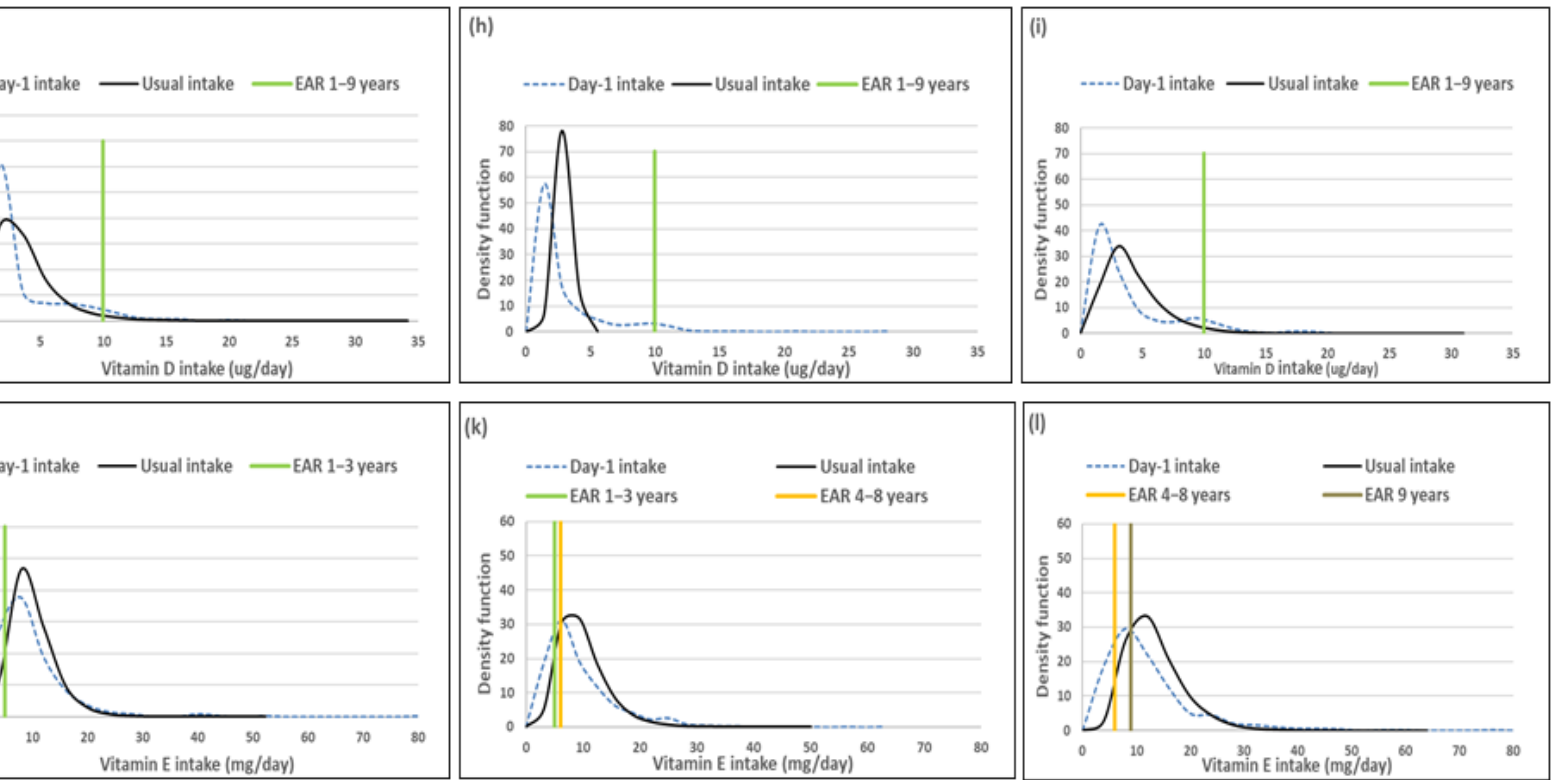
Figure 2. Distributions of the simulated, back-transformed values (usual intake) and the distribution of Day-1 intakes within the context of DRI-values of vitamins A, C, D and E, by age group. ( a ): Age 1–<3 years: Vitamin A intake; ( b ): Age 3–<6 years: Vitamin A intake; ( c ): Age 6–<10 years: Vitamin A intake; ( d ): Age 1–<3 years: Vitamin C intake; ( e ): Age 3–<6 years: Vitamin C intake; ( f ): Age 6–<10 years: Vitamin C intake; ( g ): Age 1–<3 years: Vitamin D intake; ( h ): Age 3–<6 years: Vitamin D intake; ( i ): Age 6–<10 years: Vitamin D intake; ( j ): Age 1–<3 years: Vitamin E intake; ( k ): Age 3–<6 years: Vitamin E intake; ( l ): Age 6–<10 years: Vitamin E